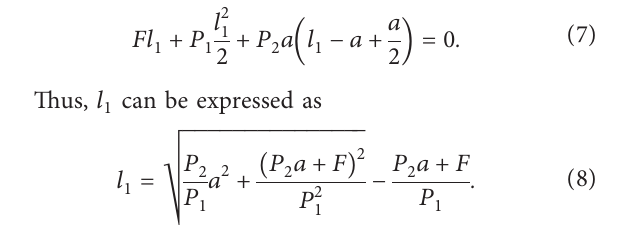
Figure 1: The mechanical model of the forward direction fault and the reverse direction fault.